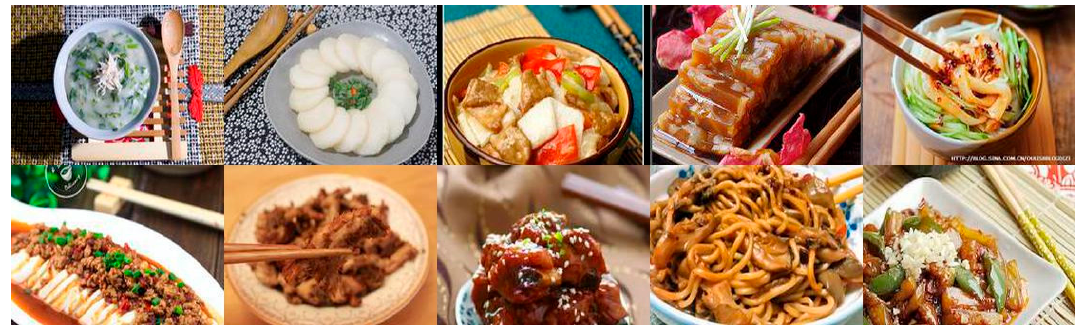
Figure 9. Examples of images with eating utensils from Xiachufang.com .